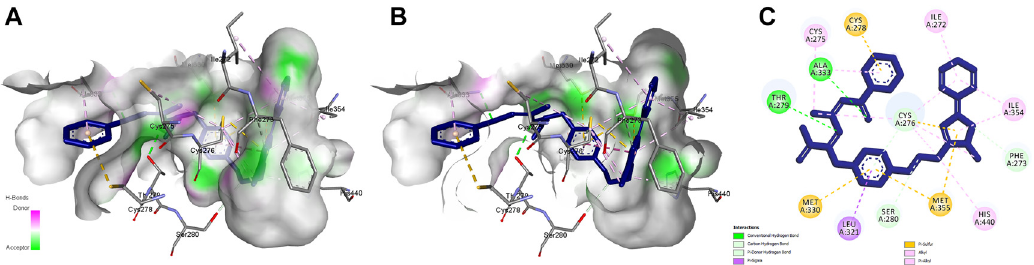
Figure3: IllustrationofwildtypePPARAinteractionwithligandatlowestbindingenergy.(A)Surfaceillustrationofligandreceptorinteraction, (B) reverse slide illustration, (C) diagram illustration of ligand receptor interaction.